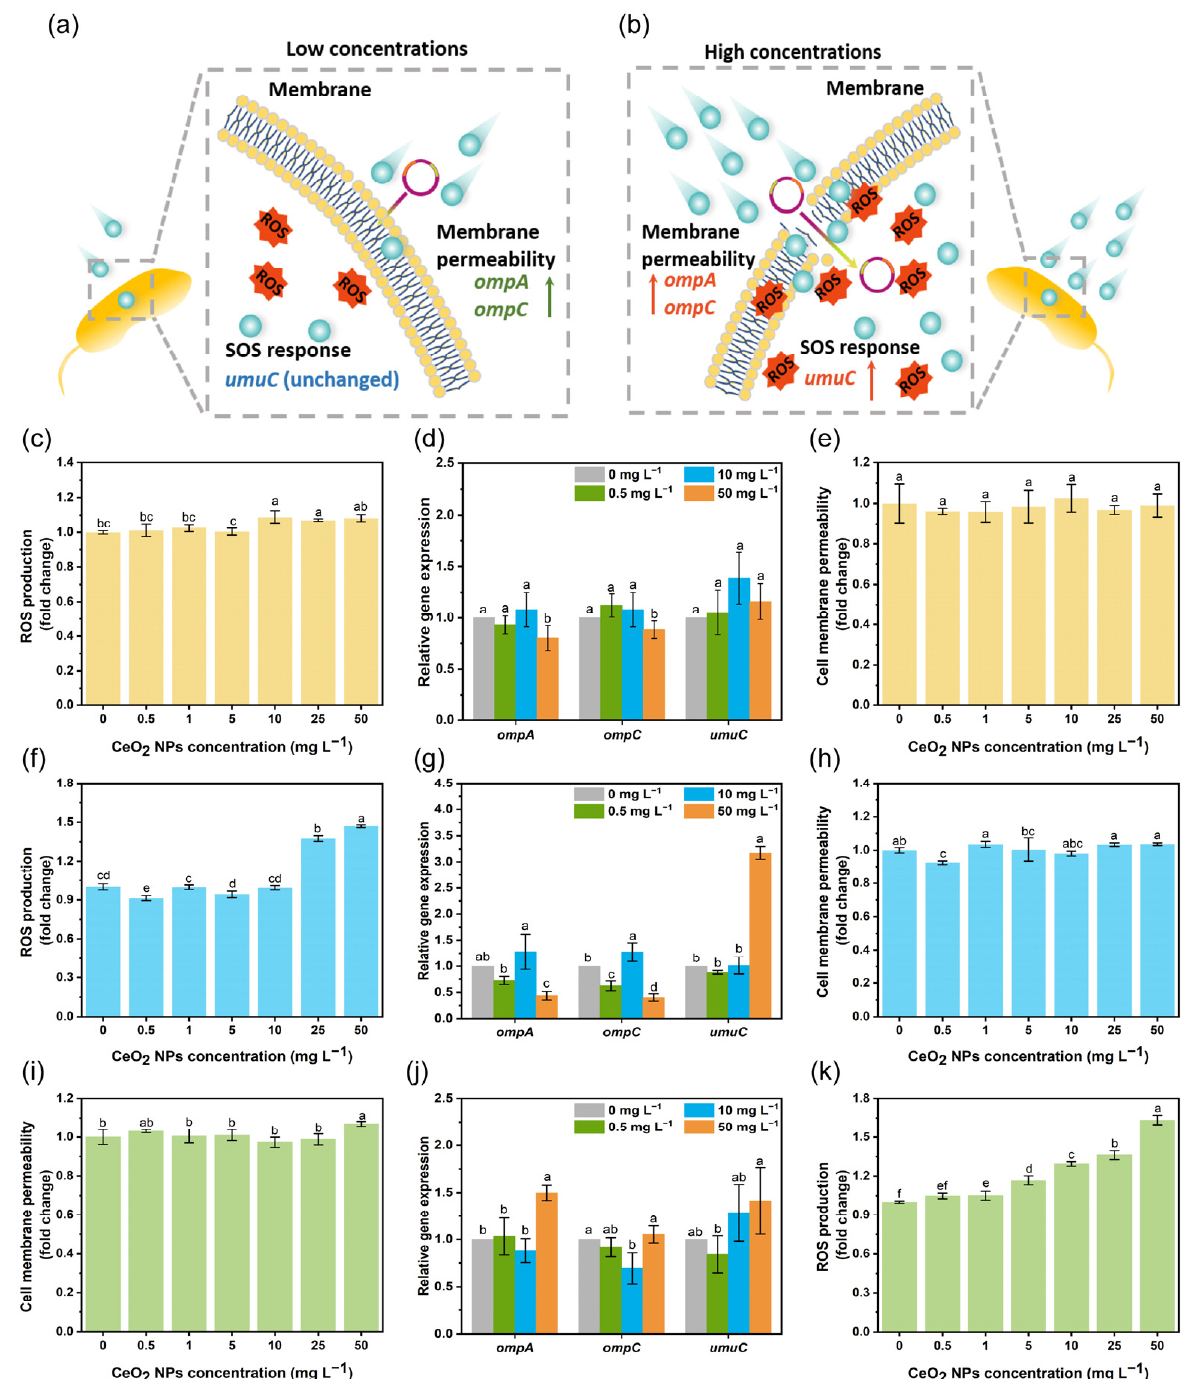
Figure 4. Effect of CeO 2 NPs on the ROS generation and cell membrane permeability. Illustrative diagrams of ROS, membrane permeability, SOS response, and corresponding gene expressions regulated by CeO 2 NPs exposure ( a , b ). Fold changes of ROS content regulated by CeO 2 NPs in System 1 ( c ). Relative gene expression in System 1 ( d ). Fold changes of cell membrane permeability regu- lated by CeO 2 NPs in System 1 ( e ). Fold changes of ROS content regulated by CeO 2 NPs in System 2 ( f ). Relative gene expression in System 2 ( g ). Fold changes of cell membrane permeability regu- lated by CeO 2 NPs in System 2 ( h ). Fold changes of cell membrane permeability induced by CeO 2 NPs in System 3 ( i ). Relative gene expression in System 3 ( j ). Fold changes of ROS content induced